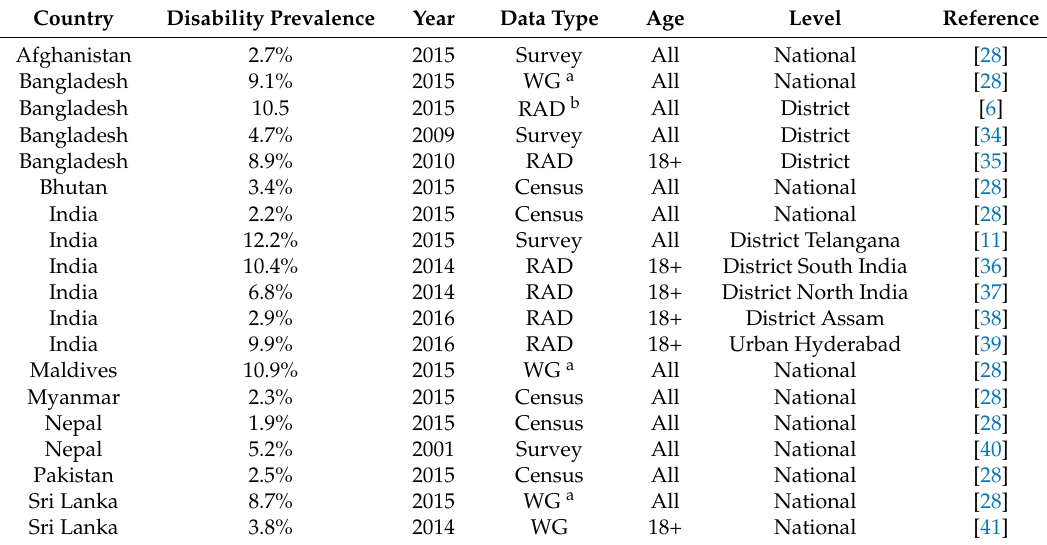
Table 1. Available Disability Data from South